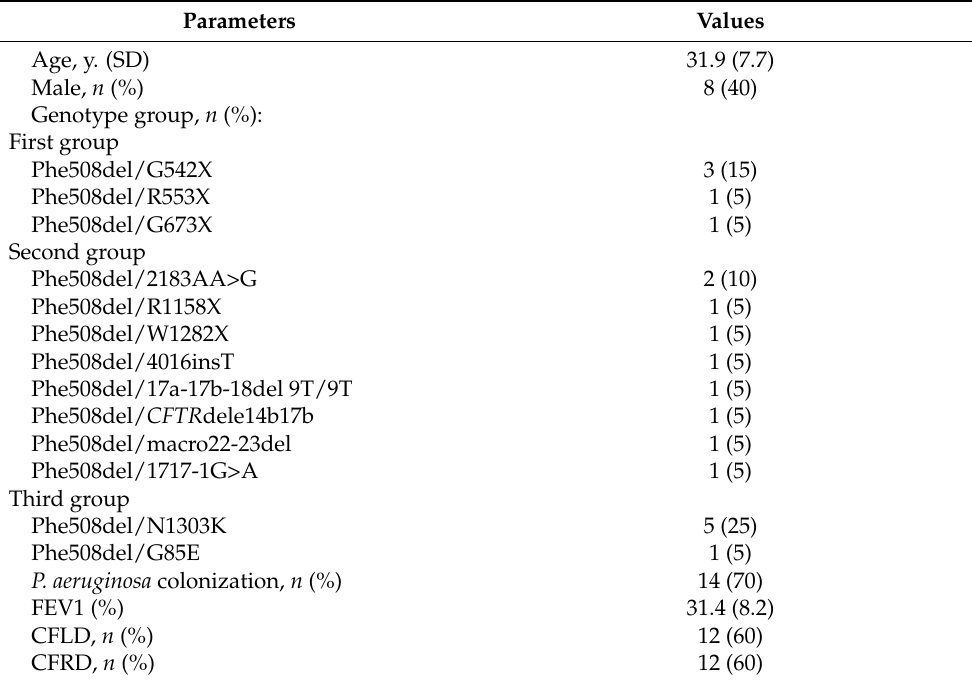
Table 1. Patient characteristics. Continuous normal data are reported as mean (SD). Categorical data are reported as frequency (percentage). CFLD: CF-associated liver disease; CFRD: CF-related diabetes; FEV1: forced expiratory volume in the 1st second. Parameters